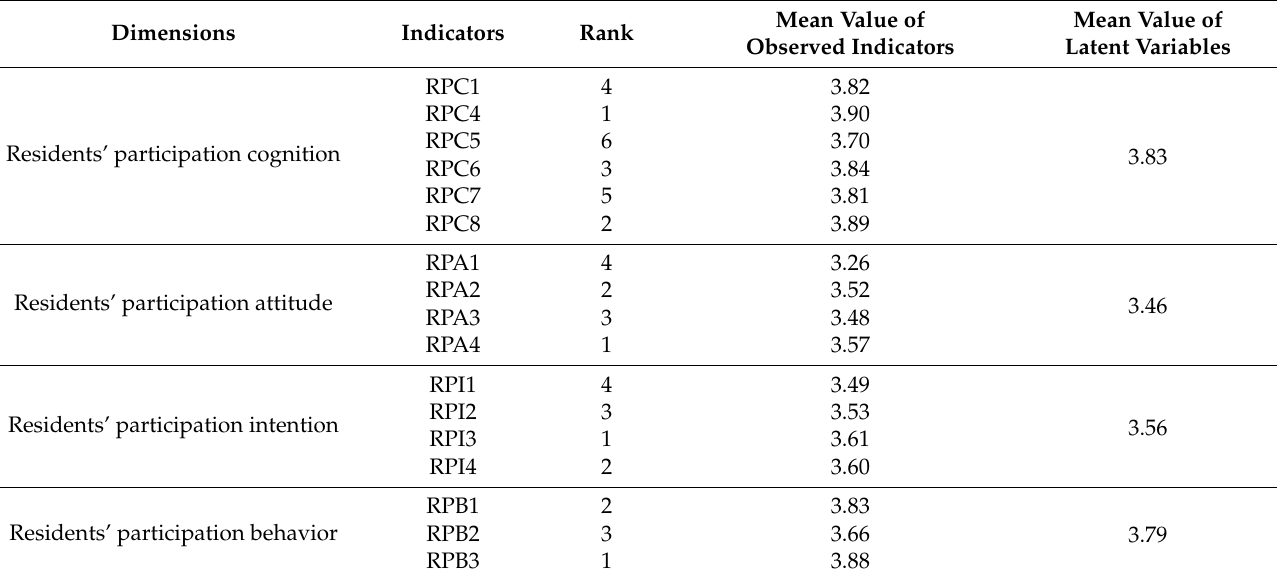
Table 2. The mean value of latent variables and ranking of observed indicators in different dimensions.